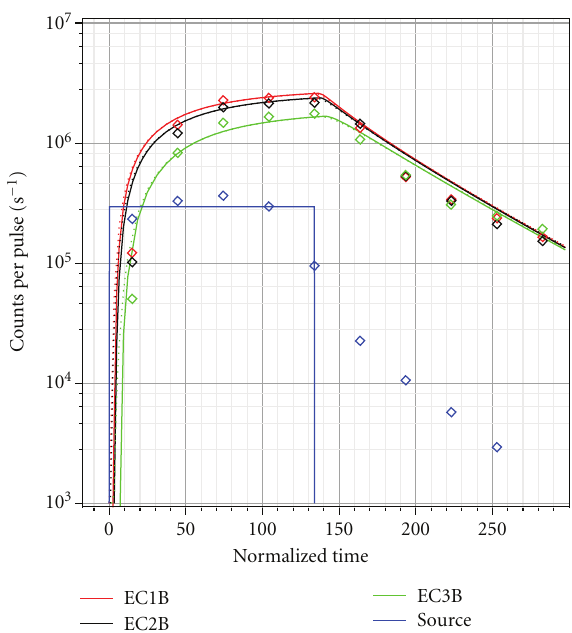
Figure 7: Comparison of the analytical results for the space-time dependent neutron flux (full line— P 1 transport; dotted line— di ff usion) with the results for the SC3A experiment at the YALINA- Booster facility on logarithmic scale.